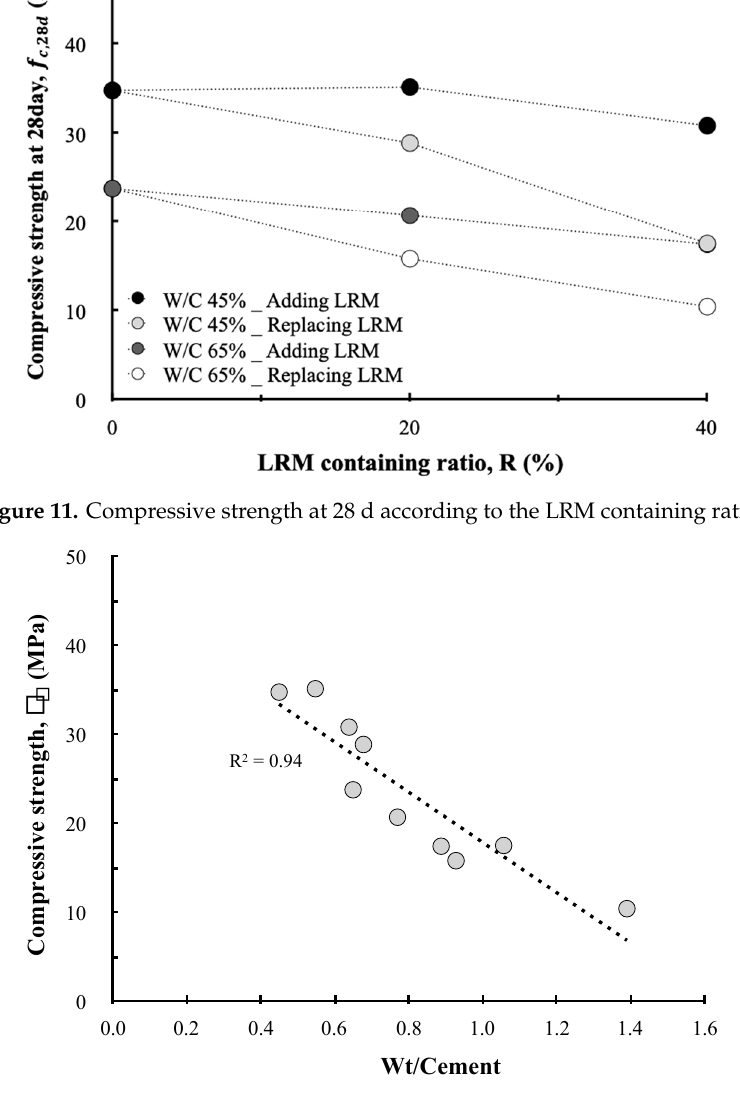
as a function of Wt / c